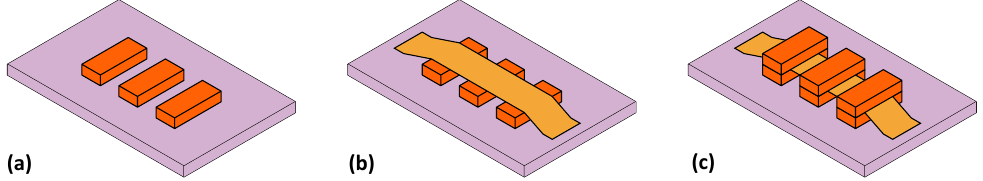
Figure 3. The printing process for creating a mechanism: ( a ) the initial layers were printed onto the print bed, ( b ) a pause was introduced through modified g-code and the flexible layer was applied, ( c ) printing resumed, a Z offset can be applied to reduce interference on thick